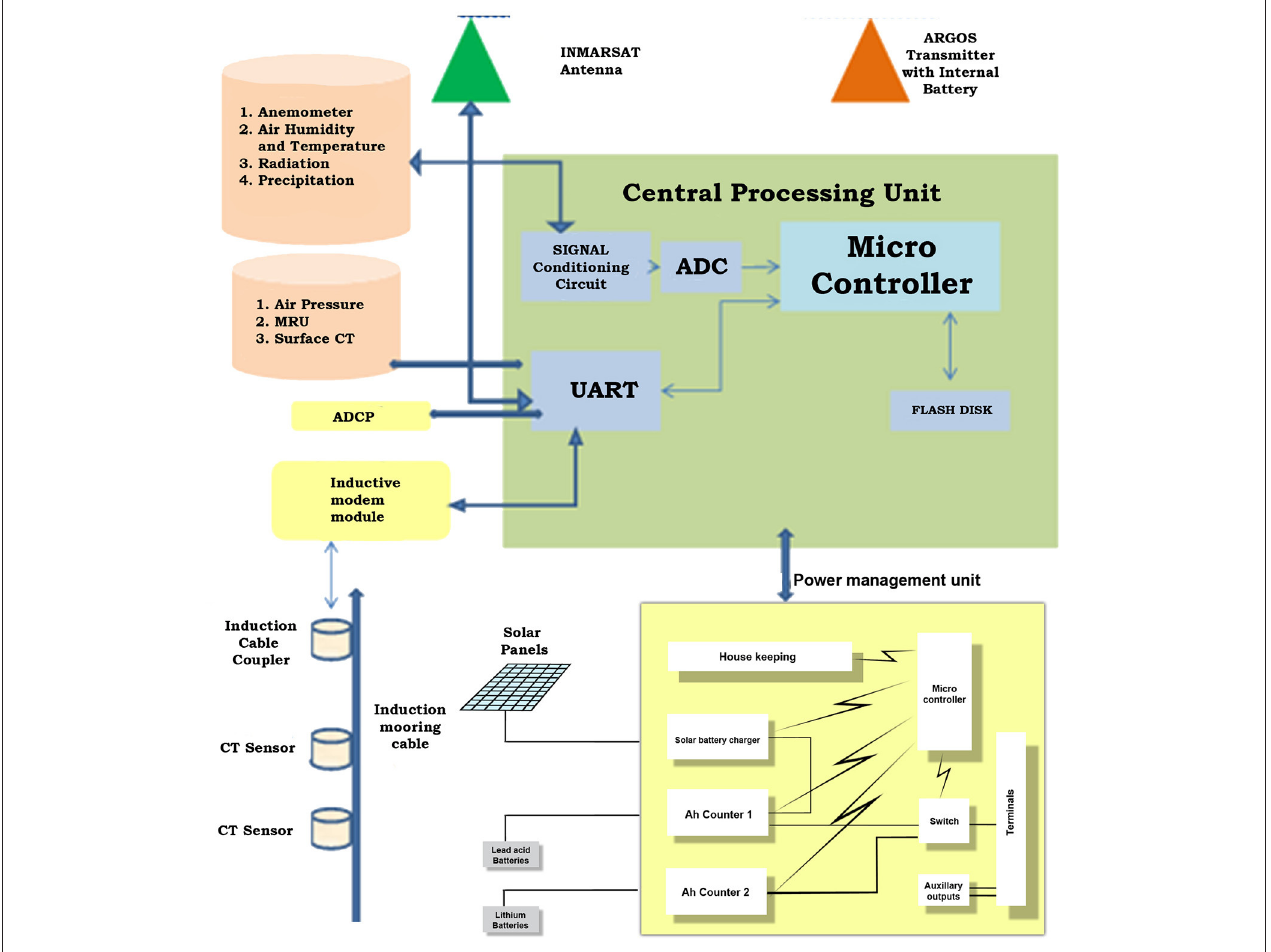
FIGURE 3 | Moored buoy power